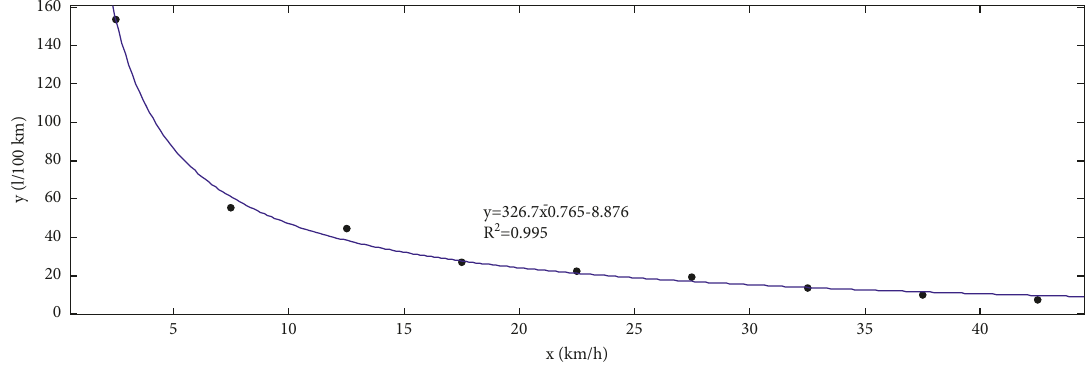
Figure 9: The correlation between average bus fuel consumption and average bus